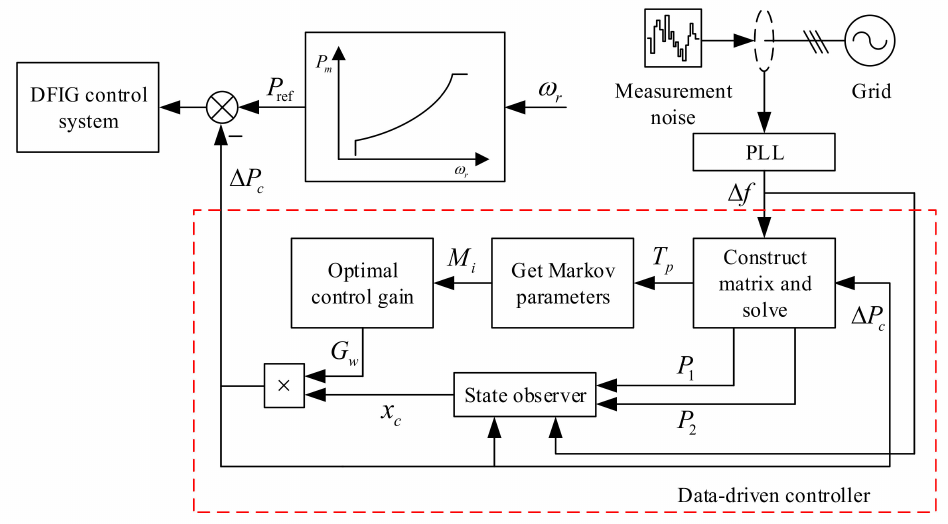
Figure 4. The diagram of data-driven inertia controller for DFIG-based wind